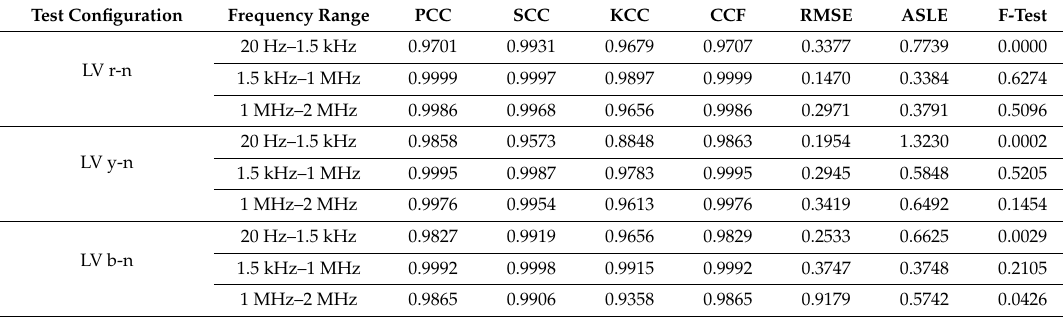
Table 3. Comparison of statistical methods for frequency response interpretation of LV winding.